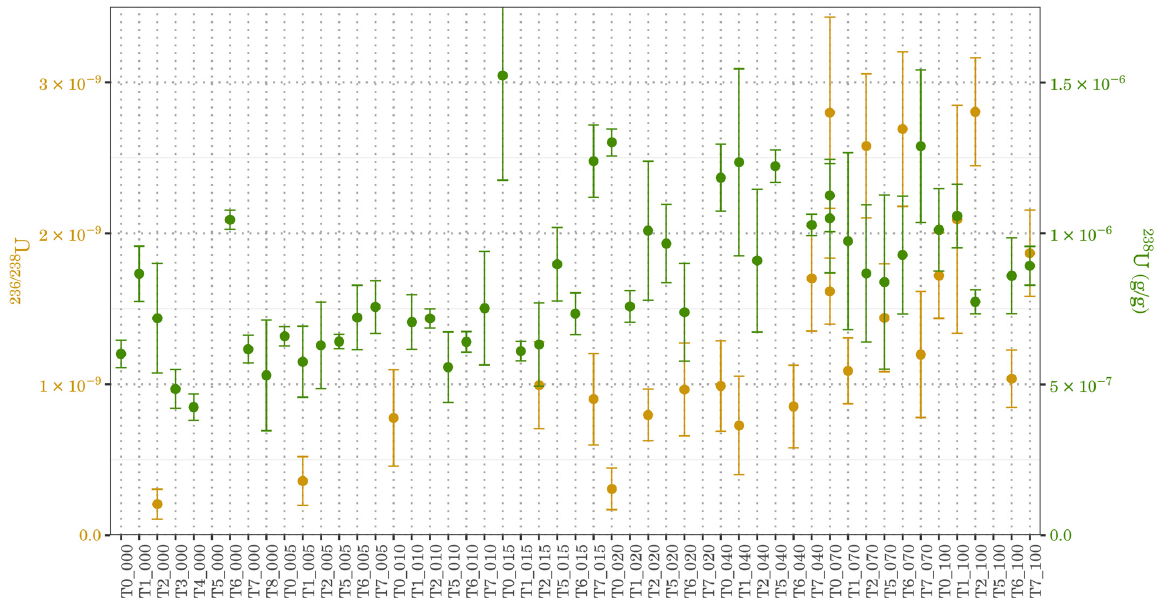
Figure 10. 236/238 U isotopic ratio (in orange, on the left) and 238 U concentration (in green, on the right) in marine sediments. The samples in abscissa are arranged by increasing depth of sampling. Values below the detection limit are not shown.